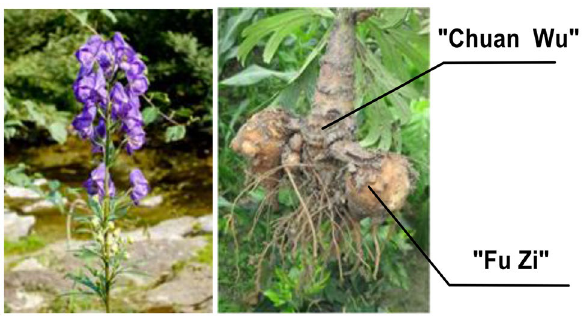
Fig. 1 The lateral roots of A. carmichaelii